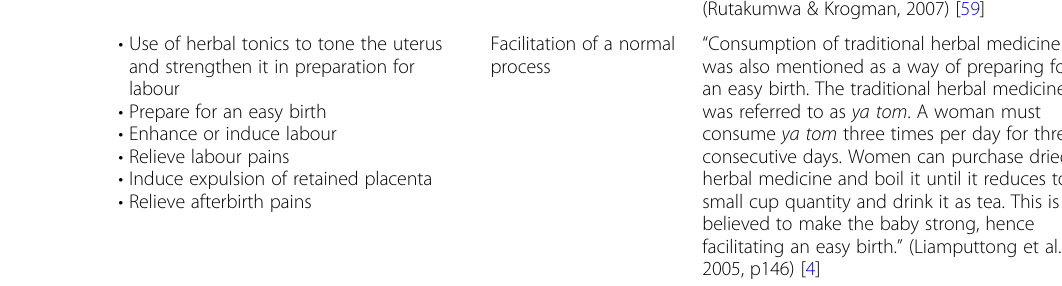
Table 3 Thematic analysis: women ’ s use of CMPs in pregnancy and lactation and perceived benefits (Continued)